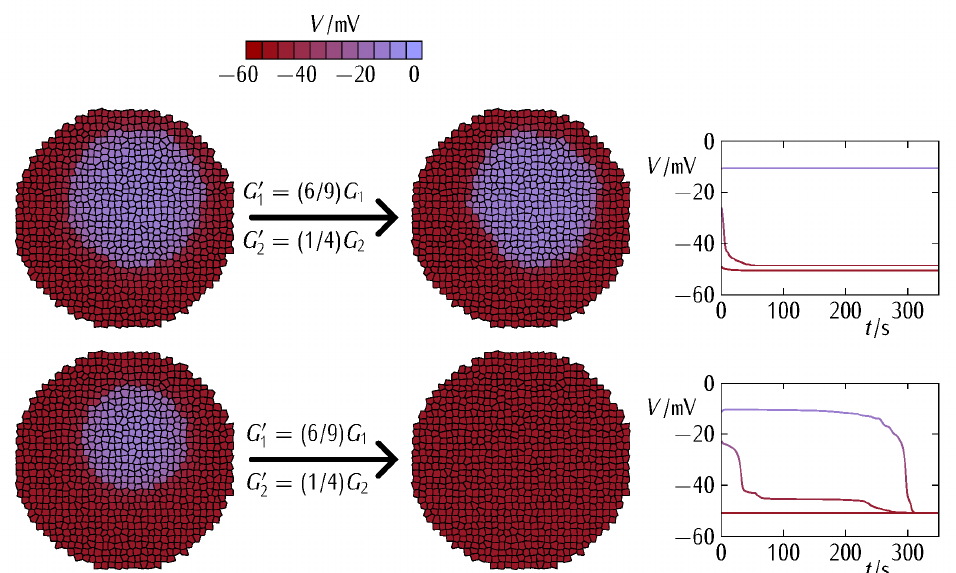
Figure 6. The effect the patch size on the bioelectrical normalization caused by the polarized bulk at constant junction conductance decreases. While the decrease of the intercellular connectivity in the patch allows complete normalization for small sizes ( bottom ), big enough patches can still resist normalization because of the enhanced community effect ( top ). Note that this size effect should also depend on the nature of the heterotypic conductance at the interface between the patch and the surrounding bulk, as suggested by Figure 3. The other system parameters are those of Figure 4.